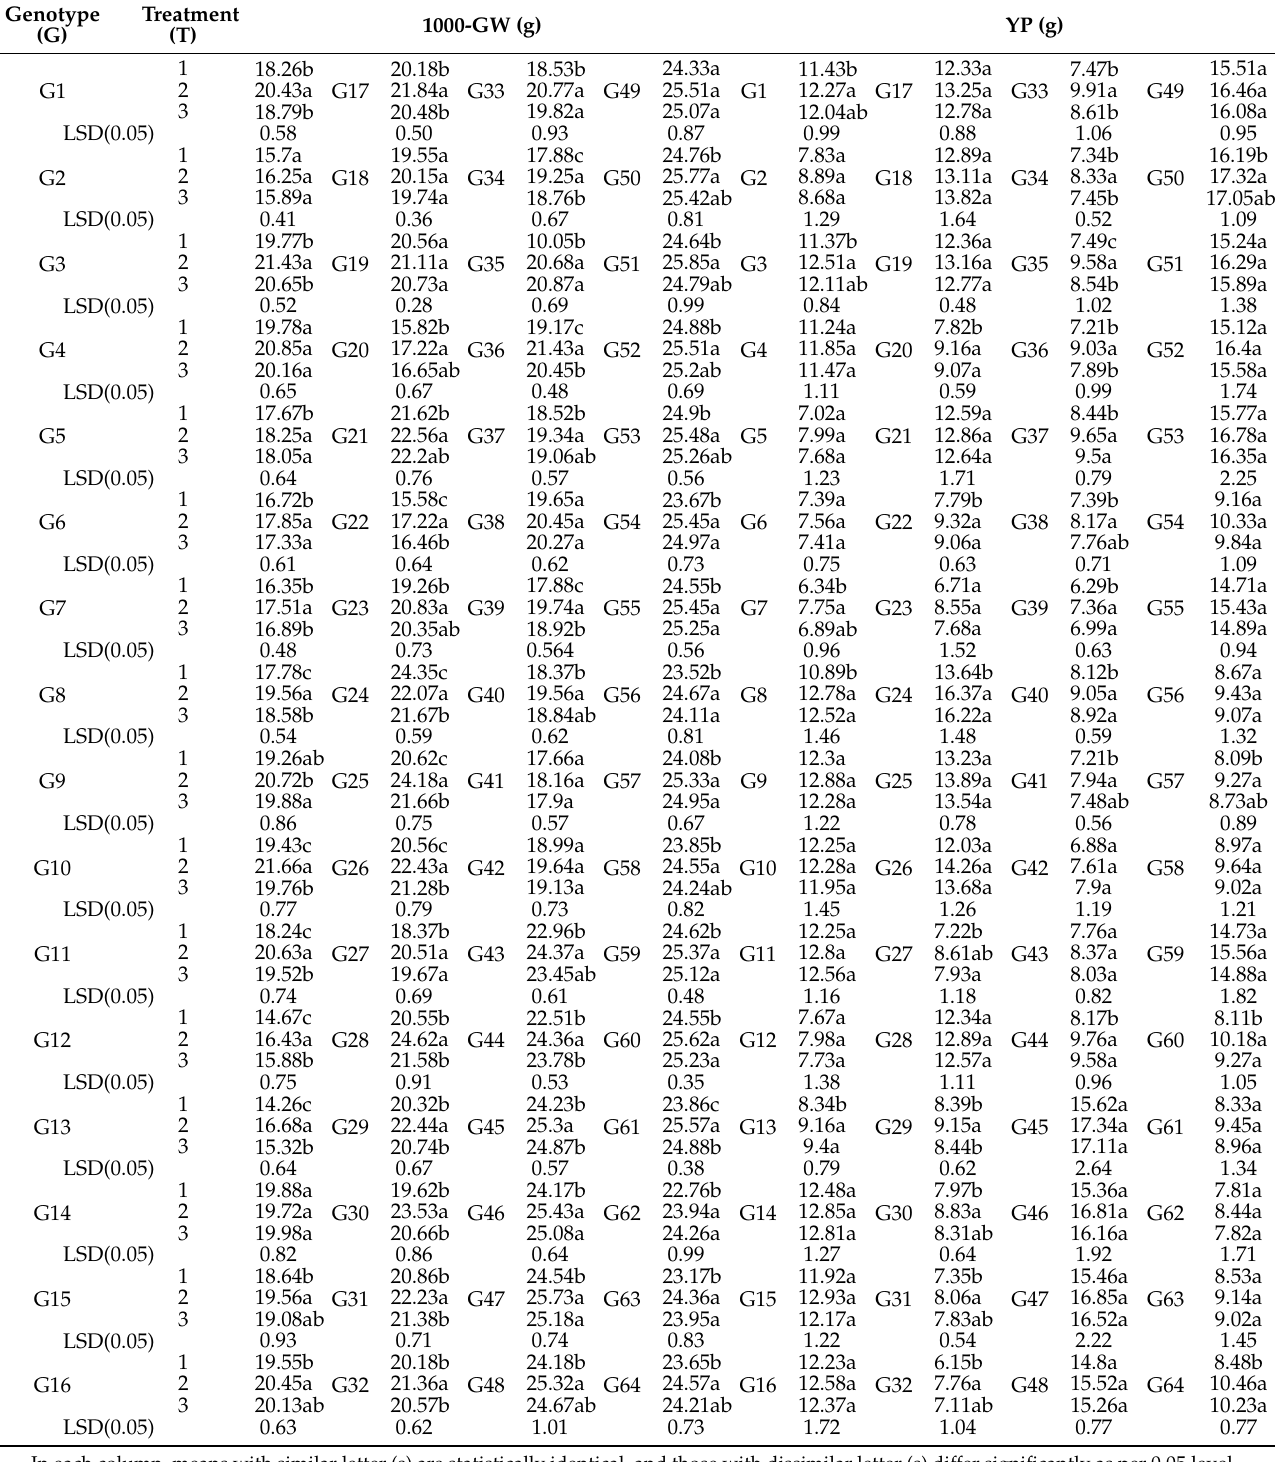
Table 9. 1000-grain weight and yield per plant of 64 rice genotypes as influenced by treatment and genotype (pooled over two